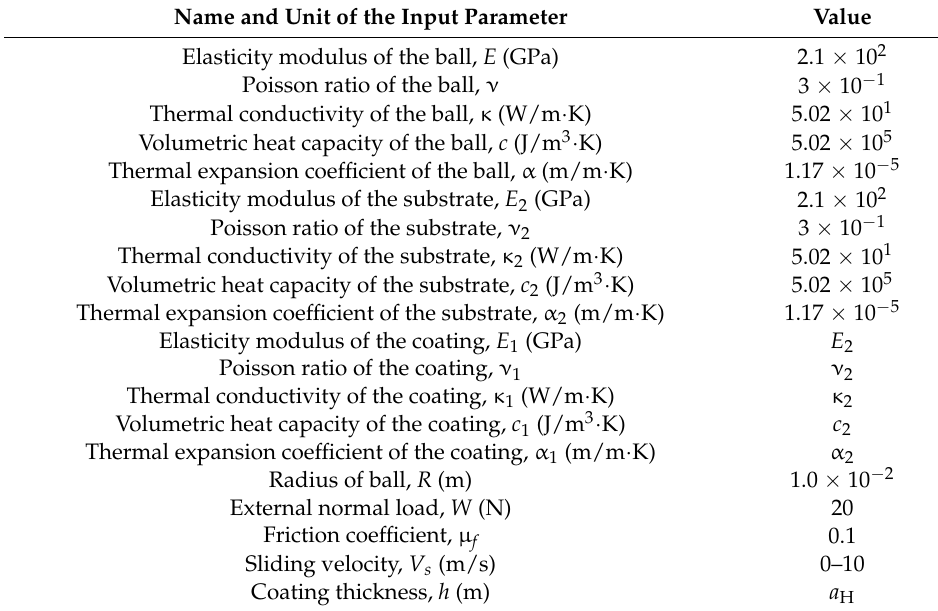
Table 1. Input parameters of present model for simulating the thermoelastic contact between a homogeneous solid and an elastic